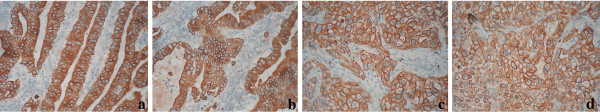
Immunohistochemical staining of MTA3 in lung cancer tissue sections. a and b: Positive MTA3 staining in a case of lung adenocarcinoma. c and d: Positive MTA3 staining in a case of squamous cell carcinoma.